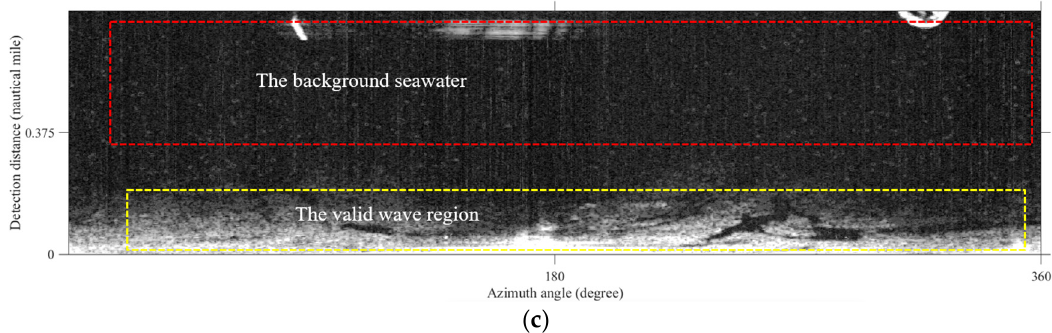
Figure 5. Training data: ( a – c ) were different radar images concluding oil spills.